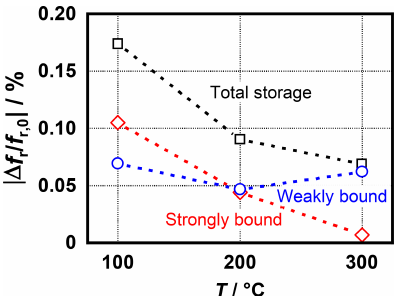
Figure 8. Frequency shift caused by strongly and weakly bound ammonia at different sensor temperatures measured with the opti- mized sensor design.